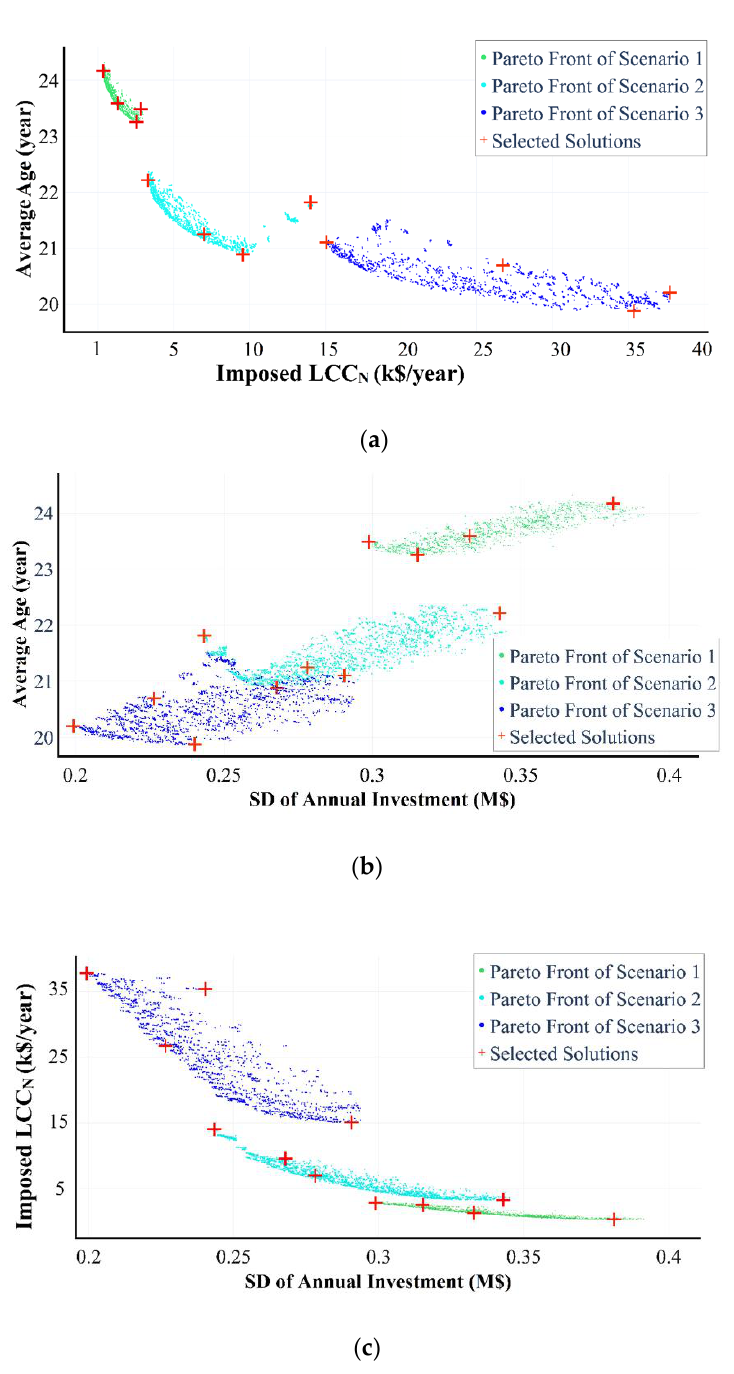
Figure 7. Comparison of nondominated Pareto solutions for three scenarios.